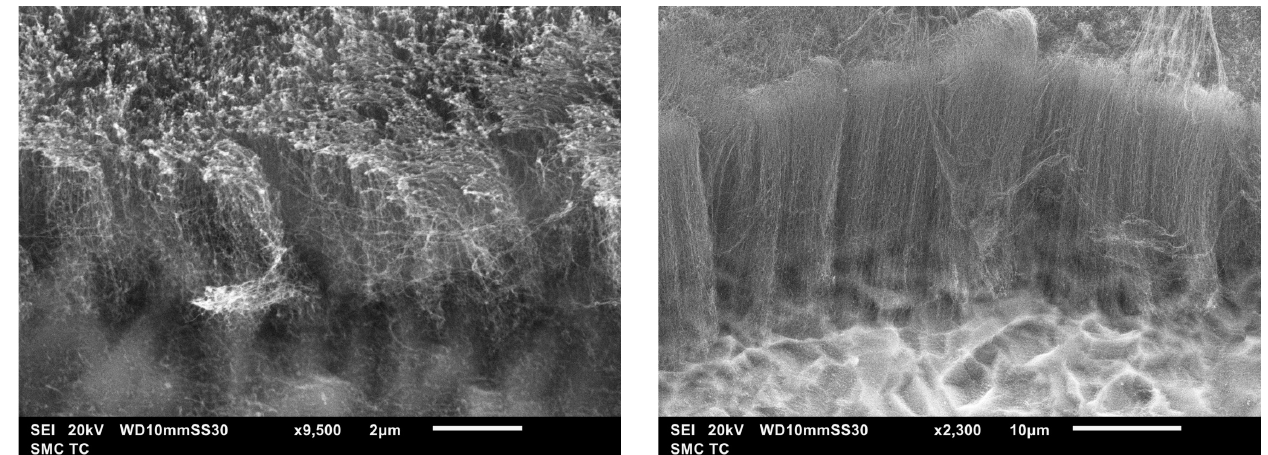
Figure 5. SEM image of a grown MWCNT array on a titanium plate used by us for preparation of PANI-MWCNT